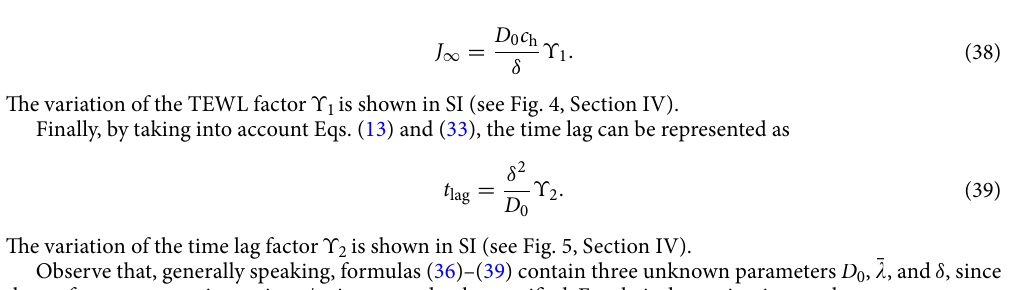
Figure 6. ( a ) Variation of the right-hand side of Eq. (42); ( b ) Variation of the dimensionless